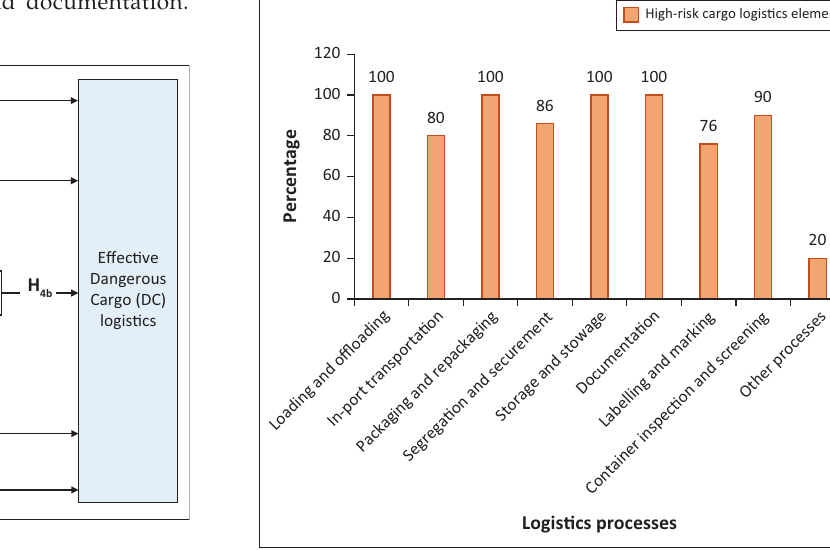
FIGURE 2: Conceptual framework of the study. FIGURE 3: Elements of high-risk cargo logistics TABLE 2: Level of factors influencing the effectiveness of high-risk cargo logistics. Factors